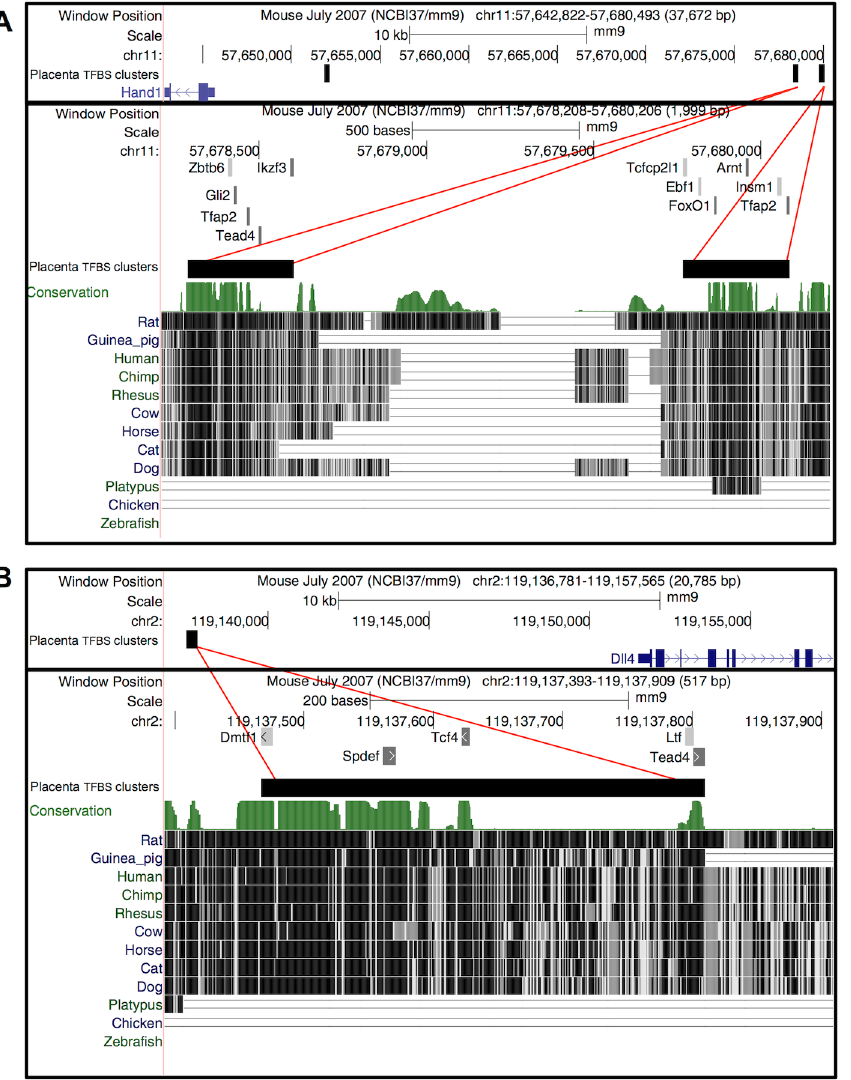
Figure 4. Placenta TFBS clusters in the regulatory domain of genes with important roles in placenta development. Hand1 (A) and Dll4 (B) contain placenta TFBS clusters in their regulatory domains. Placenta TFBS clusters that were tested are shown in the lower panel of each figure along with representative binding sites that were predicted over them. Binding sites for TFs that have a known role in placenta development are shaded dark gray, whereas bindings sites for TFs that have a predicted role in placenta development are shaded in light gray.